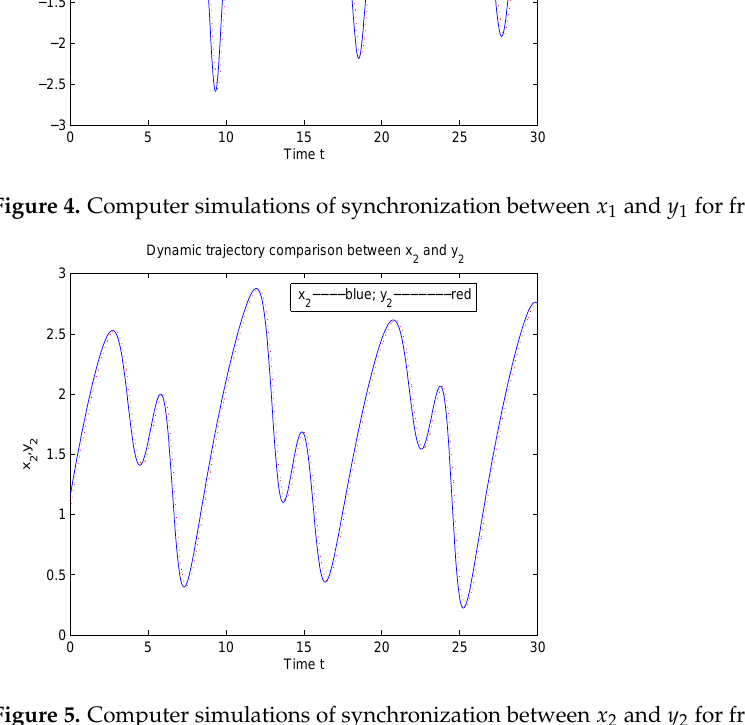
Figure 5. Computer simulations of synchronization between x 2 and y 2 for fractional-order